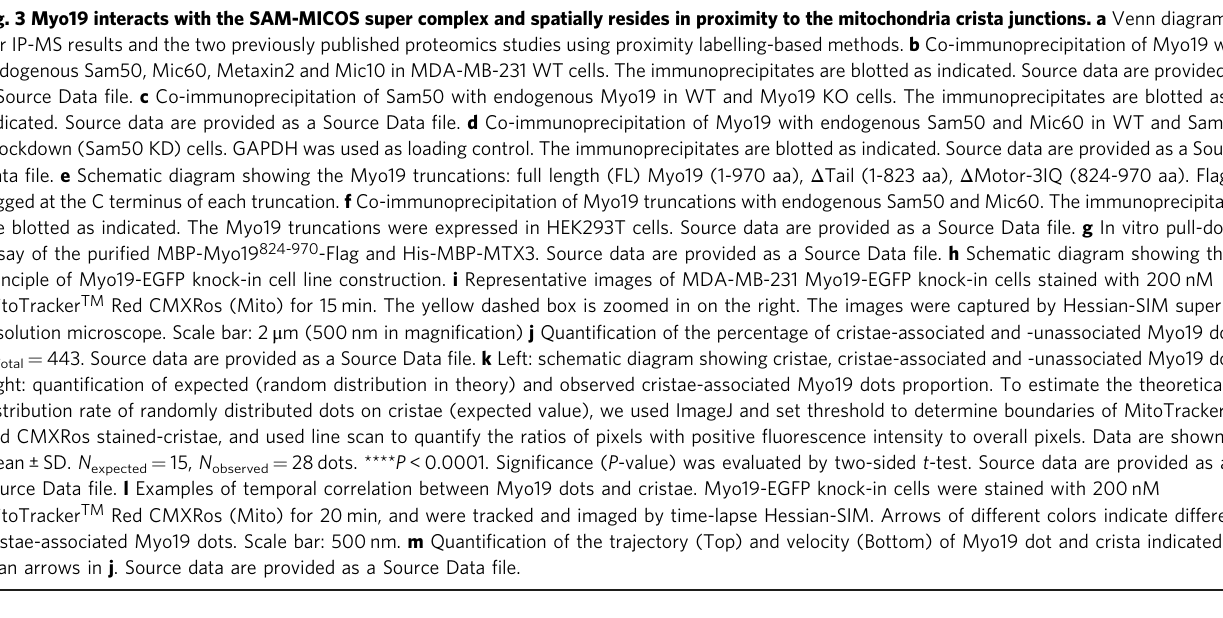
Fig. 7a, c). Yang and Svitkina have previously demonstrated that